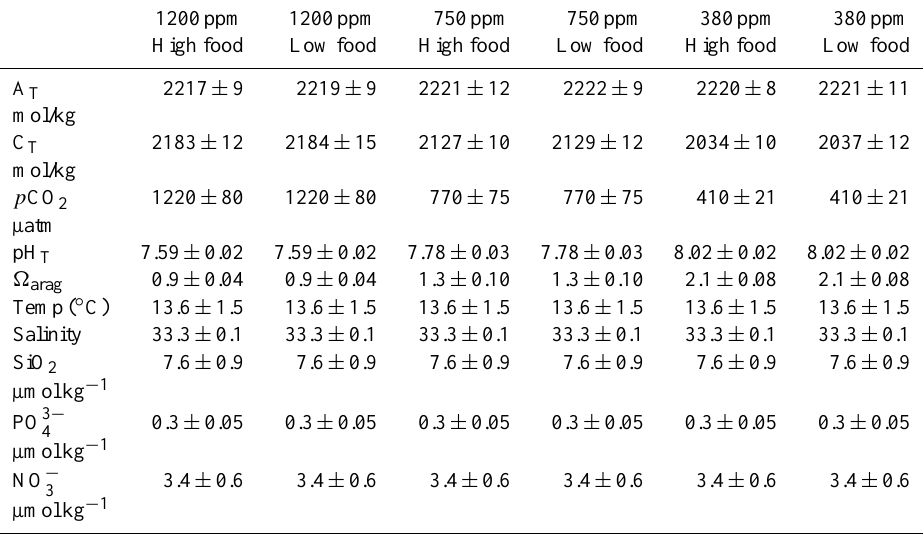
Table 1. Mean ± standard deviation (s.d.) of experimental chemical conditions from November 2011 to July 2012. High-food corals were fed once every 3days, and low-food corals were fed once every 21days. 1200ppm 1200ppm 750ppm 750ppm 380ppm 380ppm High food Low food High food Low food High food Low food A T 2217 ± 9 2219 ± 9 2221 ± 12 2222 ± 9 2221 ± 11 mol/kg C T 2183 ± 12 2184 ± 15 2127 ±